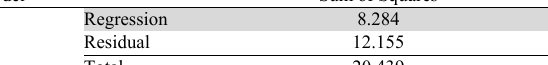
F-test results of supply chain management practice Model